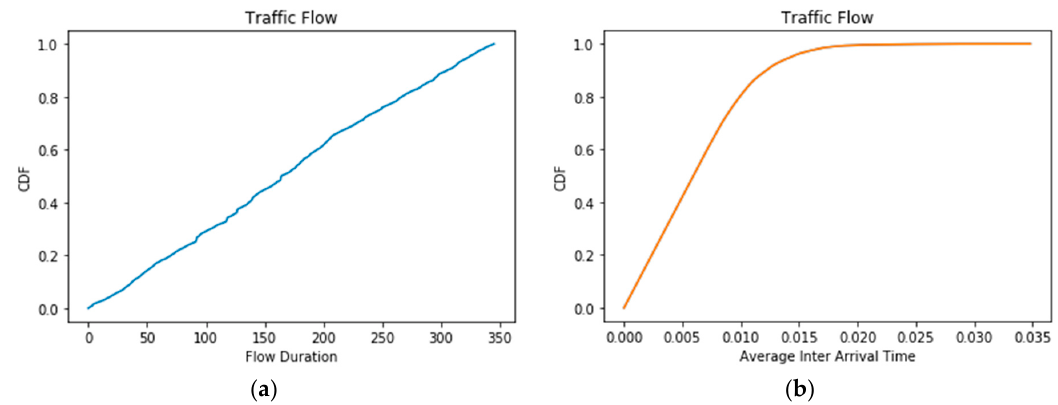
Figure 3. Flow duration ( a ) and inter-arrival time ( b ). ( a ) Distribution of flows duration. ( b ) Distribution of average flow inter-arrival time. Table 1. Statistics of a packet from di ff erent data flows from the